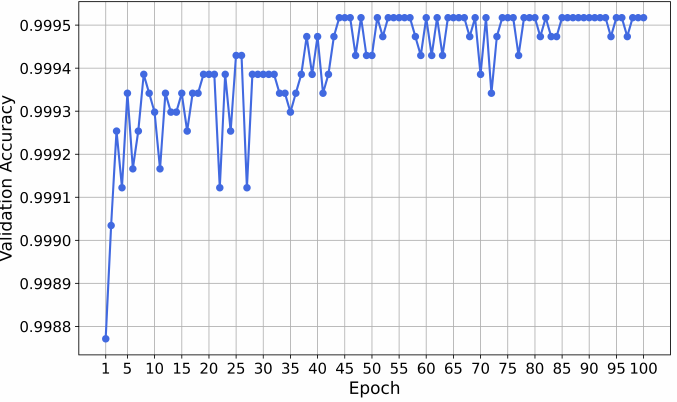
Figure 4. Validation accuracy of the neural network for each